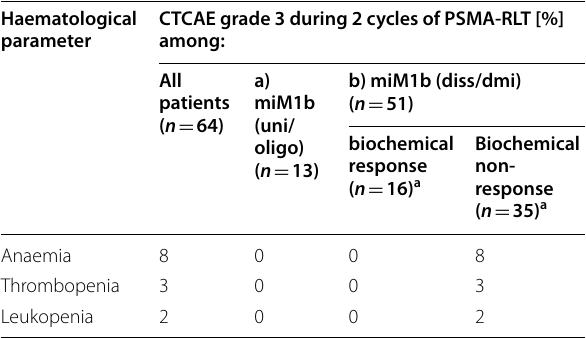
CTCAE Common Toxicity Criteria for Adverse Events version 5.0 [10], = miM1b bone involvement categorised according to PROMISE criteria [25] = a According to Prostate Cancer Working Group criteria v. 3 [20]